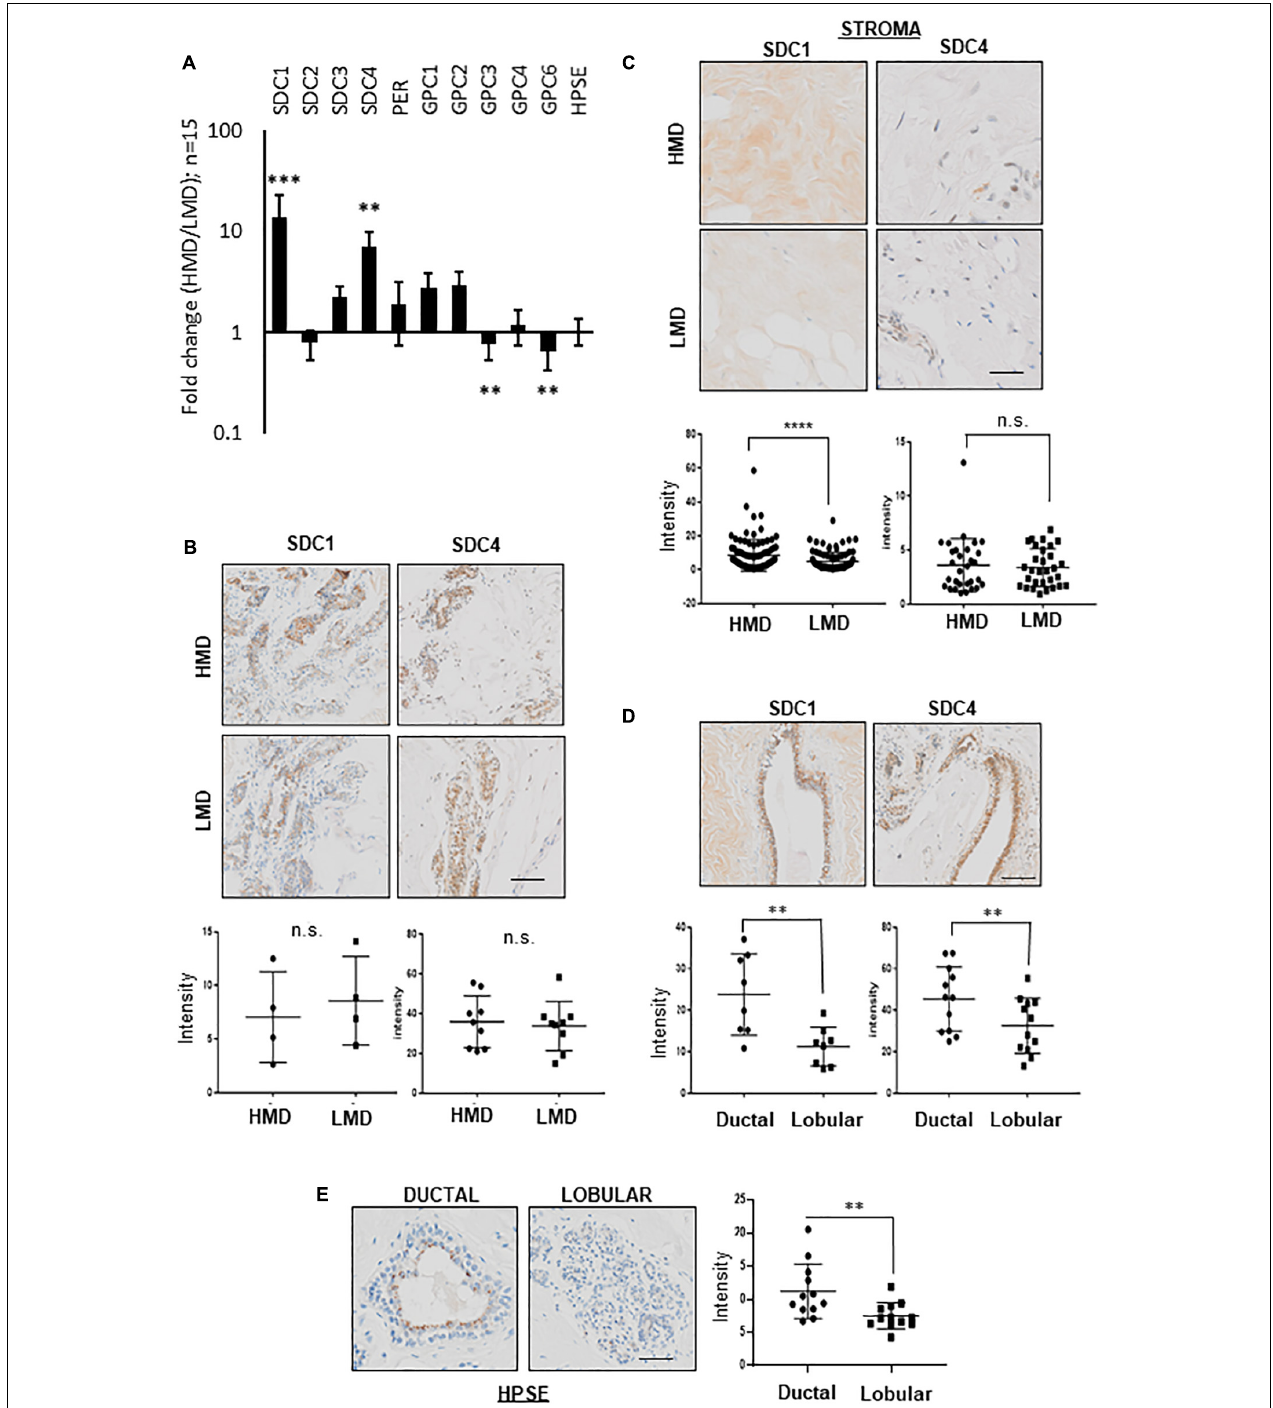
FIGURE 1 | PGs expression in HMD vs. LMD. (A) RT-qPCR for various HSPG proteins and HPSE (HPSE) in HMD vs. LMD paired patient tissue. Fold change (HMD/LMD) gene expression from 15 patients, plotted on a logarithmic Y-axis. Delta CT values were obtained using L32 as the housekeeper gene, then converted to ddCT (2 CT ) for all fold change calculations. Student’s paired t test was used to determine significance, where ∗∗ p < 0.001 and ∗∗∗ p < 0.0001. Significance was achieved after adjustment for multiple testing. (B) Assessment of SDC1 and SDC4 protein expression in HMD vs. LMD tissues. Representative IHC images are displayed with intensity data (% DAB positivity per tissue area) plotted underneath. Lobular epithelium, n = 4 pairs for SDC1, n = 9 pairs for SDC4; (C) Stromal regions, n = 35 pairs for SDC1, n = 30 for SDC4. (D) Ductal vs. lobular epithelium (HMD only shown) for SDC1 or SDC4, n = 8 pairs for SDC1 and n = 12 for SDC4. (E) Ductal vs. lobular epithelium (HMD only shown) for HPSE, n = 12 pairs analyzed. Student’s paired T -test was used to determine significance, where p < 0.001 is indicated by ∗∗ and p < 0.0001 is indicated by ∗∗∗ . All images were captured at 10x magnification, scale bar = 50 µ M.